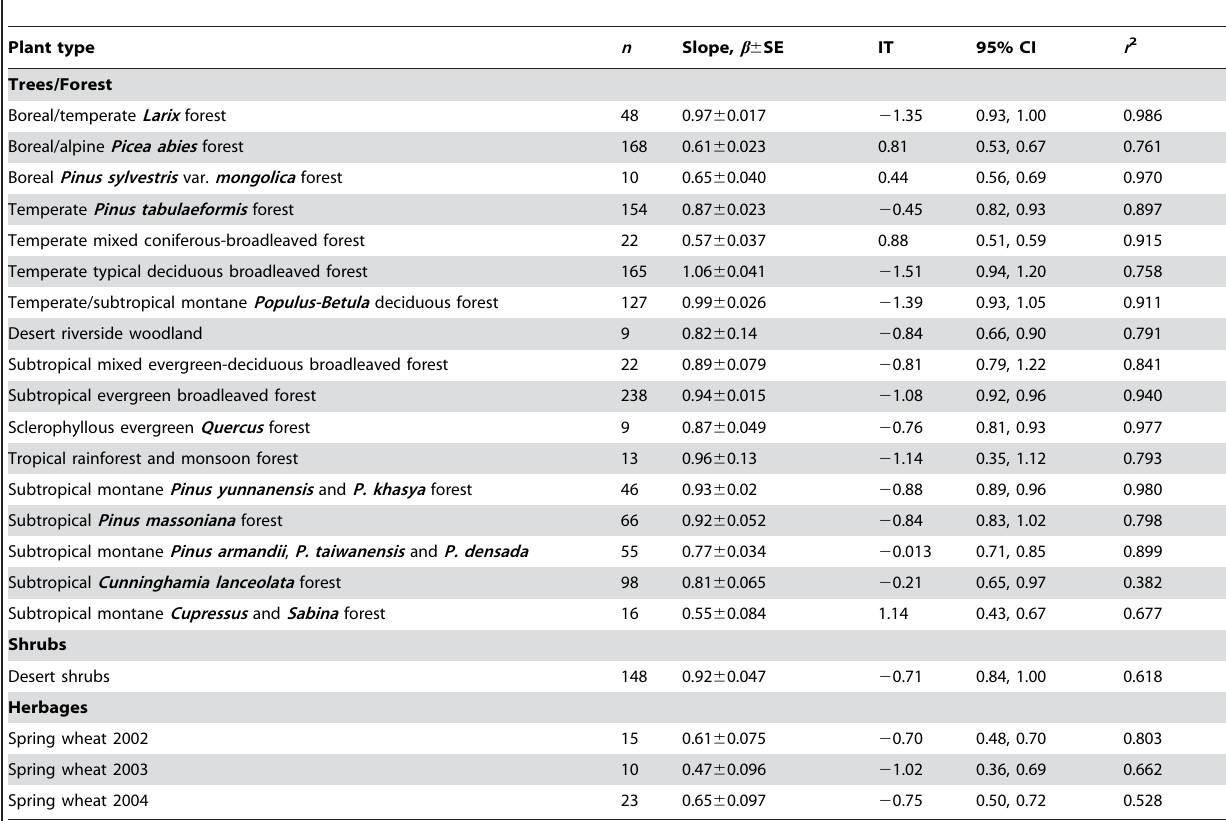
Table 1. The scaling relationship between photosynthetic biomass, M p , and the body mass, M , for trees, desert shrubs and herbaceous plants.